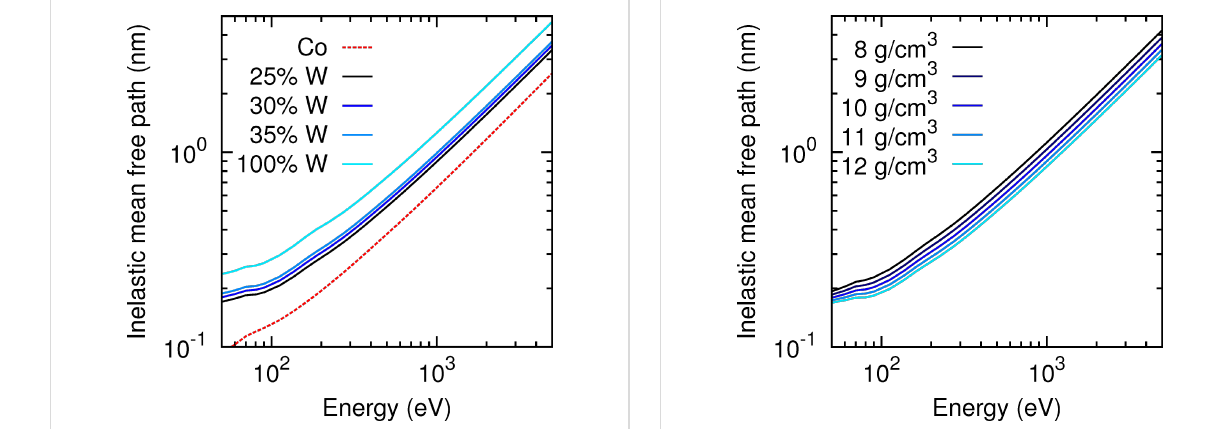
fixed W content (27.5% W, 50.4% C, 22.1% O, which corre- sponds to WC 1.75 O 0.75 ) and have varied its density from 8 g/cm 3 to 12 g/cm 3 (covering the range of densities given in Table 1). The distribution of the deposited energy and the variations in the density influence the energy deposition process in the nanostructure much more strongly than variations in the W content (in the considered variation intervals of these para- meters). This can be best observed in the case of the sample with thickness d WCO = 200 nm for z = 50–150 nm.